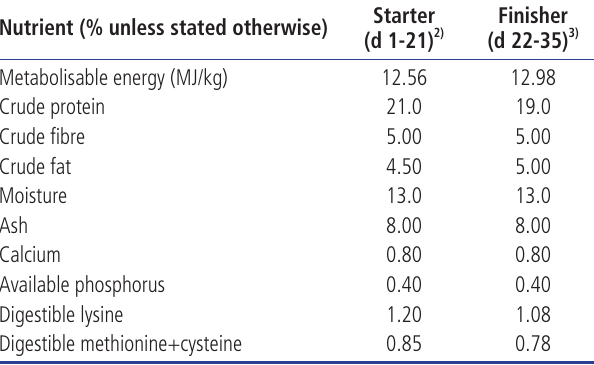
Table 1. Nutrient specifications of experimental diets